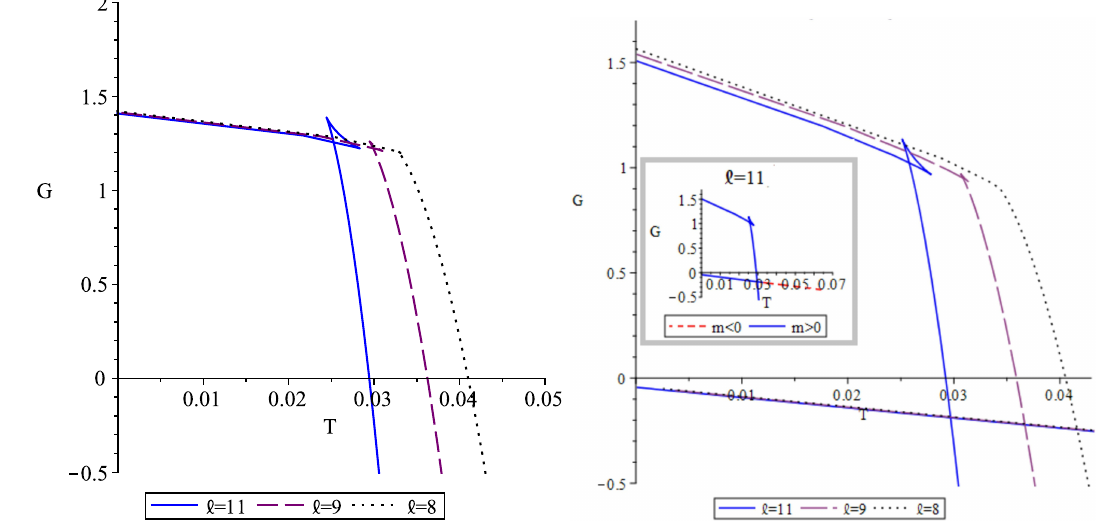
Figure 5 . Swallowtails below and above threshold pressure. Left: setting n = 1 , Q e = 1 . 4 and Q m = − 1 . 3 , we have P t = 0 . 10544 > P for all values of P (or ‘ ) shown. This situation exhibits the low-pressure swallowtail and high-pressure single-phase behaviour that takes place for n = 0 Reissner-Nordstrom AdS black holes. At the intersection of the swallowtail, there is a first-order phase transition from a large black hole to a small one as the temperature decreases. Right: setting n = 1 . 2 , Q e = 1 and Q m = 0 . 1 , we have P t < 0 , ensuring P > P t for all values of P shown (or ‘ ). There are now two branches. For one branch r + > n ; the curves exhibit the same qualitative behaviour as the diagram at the left. Along the other branch r + < n ; for all values of P these branches are nearly indistinguishable. This branch has a lower free energy than the r + > n branch at low temperatures, and so there will be a first order phase transition where these two branches intersect. However this branch will also have negative mass for sufficiently small r + , illustrated in the inset. These structures occur in cases Ia and